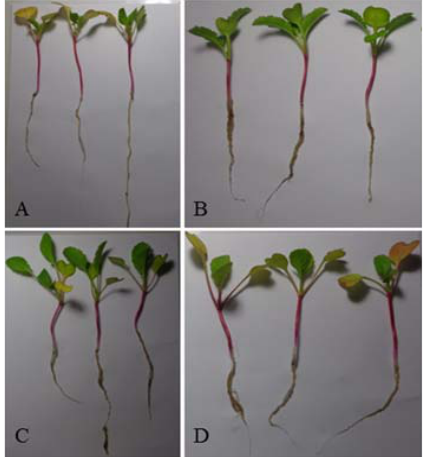
Fig. 5: Radish cultivated in soils containing A) Control, B) Ag + _bentonite, C) Ag + _phosphate and D)